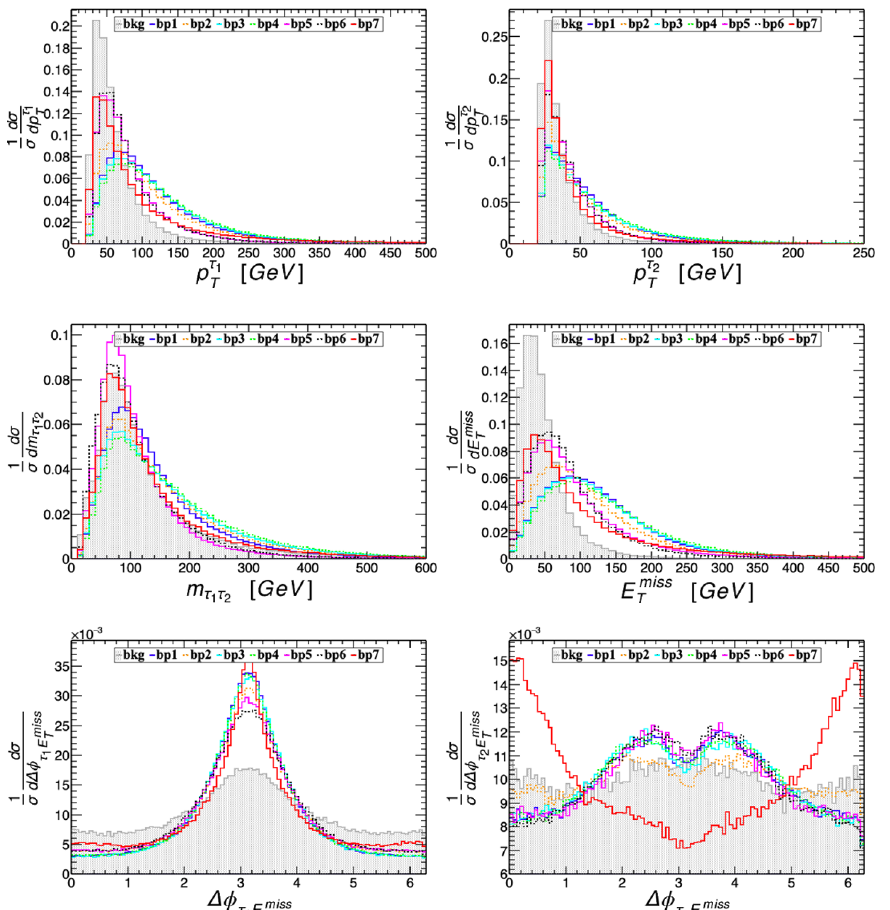
Figure 7 . Significant distributions of the 3 τ ν 2 φ channel. Gradual shift of the peaks in the top and middle panel can be attributed to the change in the mixing parameter. ∆ φ distributions shows direction of the production of missing energy signal w.r.t. τ ’s, which are clearly distinguishable from the